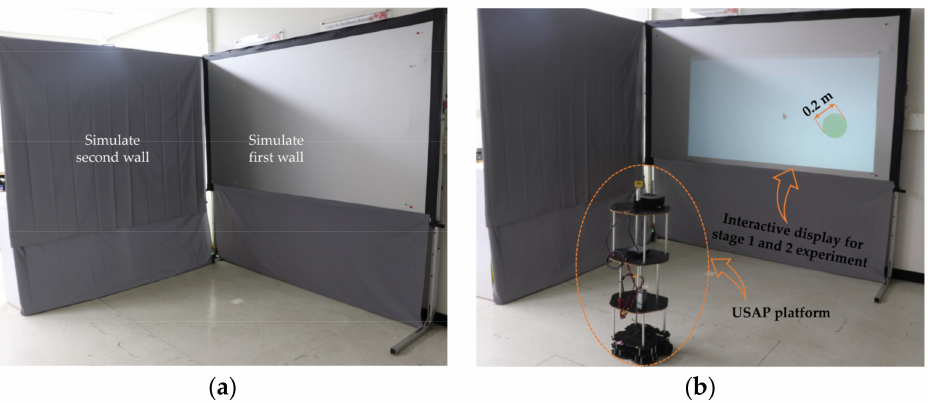
Figure 8. Experimental setup: ( a ) Two simulated walls; ( b ) the USAP platform projected onto the first simulated